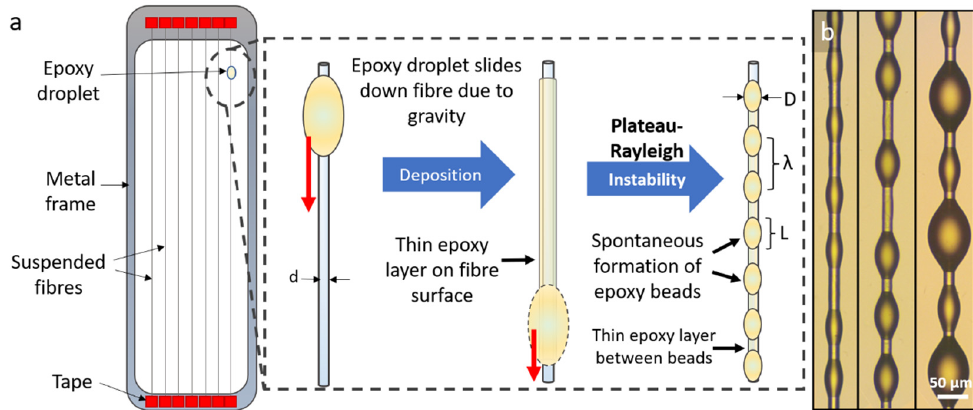
Figure 1. Preparation of beaded fibres. ( a ) Formation of fibre with intermittent epoxy beads through Plateau–Rayleigh instability [8–10]. A droplet of epoxy is placed on a suspended fibre of diameter d. As the droplet slides down the fibre, a thin layer of epoxy is formed, which spontaneously partitions into fairly uniformly spaced beads of length L, diameter D and wavelength λ . A thin layer of epoxy is observed between beads. ( b ) Cured EP828 epoxy beads of various diameters on E-glass fibres. Alternating large and small beads are typically seen when bead diameter > 70 µm.